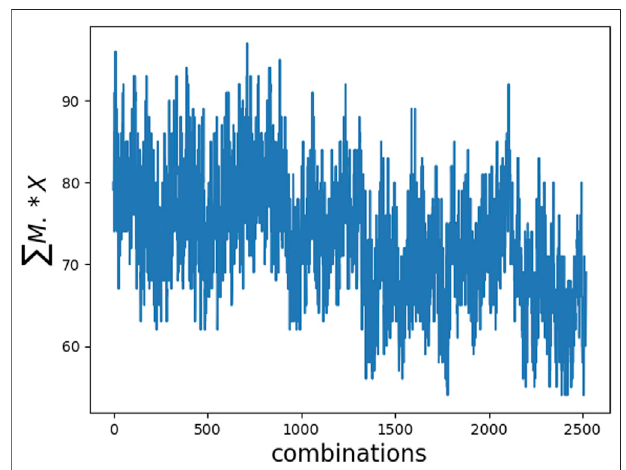
FIGURE 1 | Graph of objective function against all possible combinations for a sample